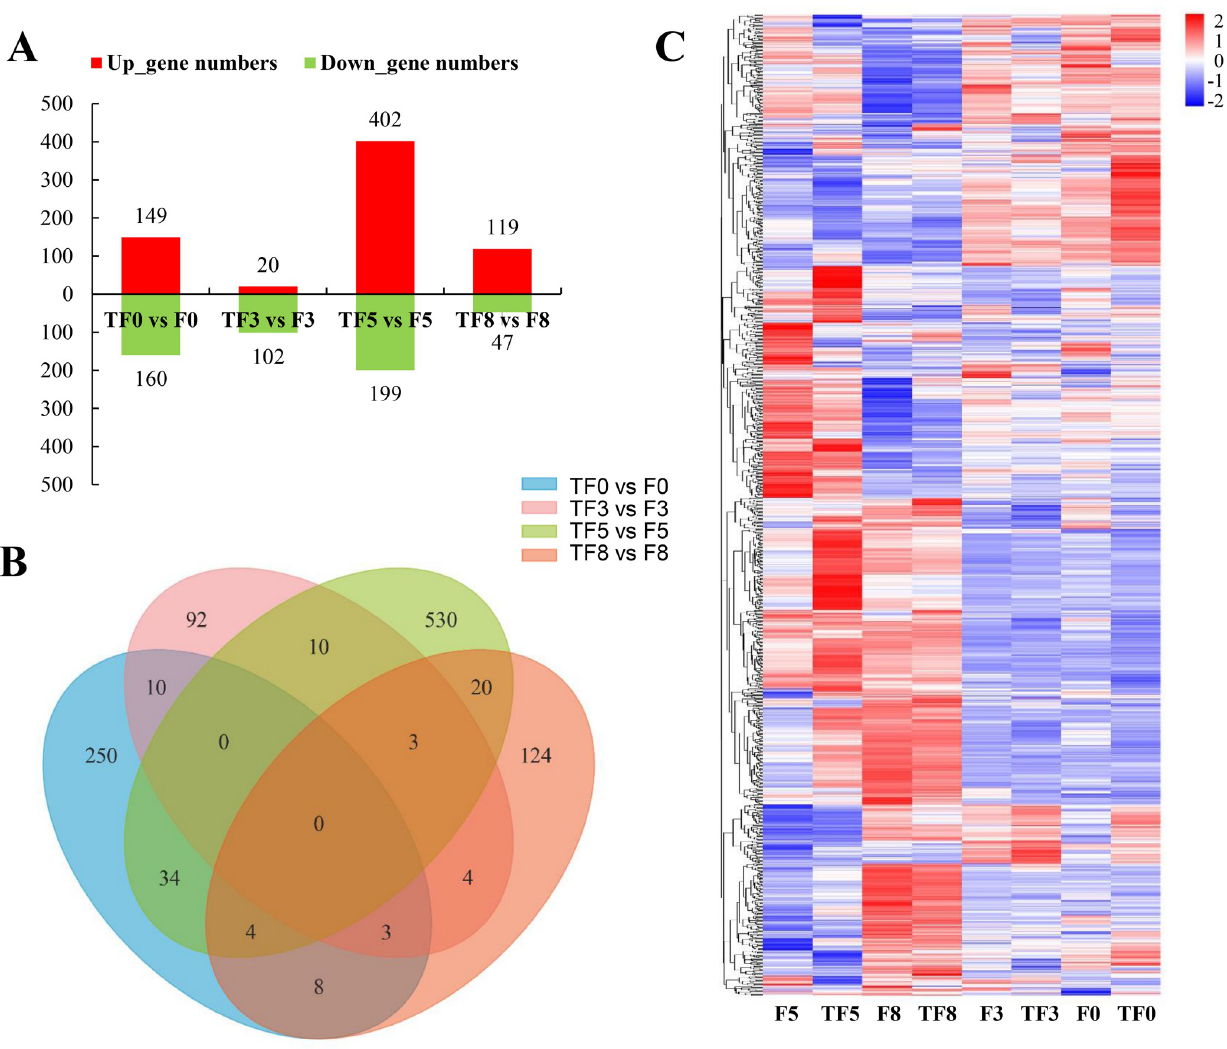
Fig 3. Differentially expressed genes (DEGs) in watermelon roots at different stages. The application of T . asperellum M45a (TF). The noninoculated control (F). A: Numbers of DEGs in the roots of watermelon treated with T . asperellum M45a and challenged with FON at different time points; B: Venn diagram of DEGs in the roots of watermelon pretreated with T . asperellum M45a and challenged with FON at different time points. C: Hierarchical cluster analysis of differentially expressed genes in the roots of watermelon treated with T . asperellum M45a and challenged with FON at different time